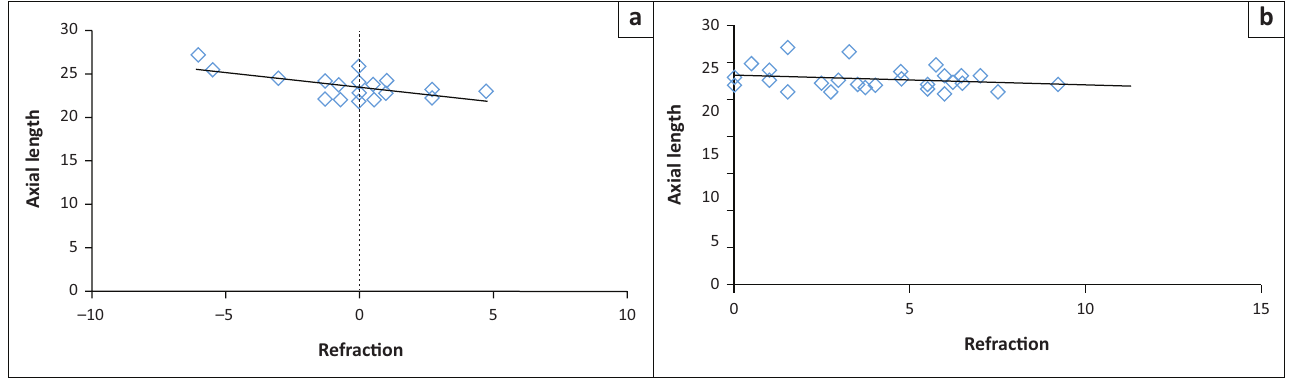
FIGURE 1: Correlation between the refractive status and axial length of the eye (a) pre-surgery and (b)